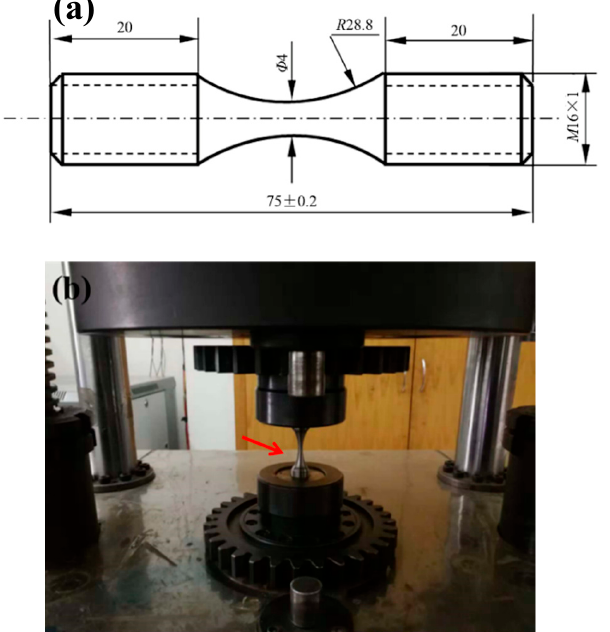
Figure 2. ( a ) Geometry of a diabolo specimen used for the uniaxial tensile fatigue test (dimensions in mm) and ( b ) the fixed fatigue specimen during HCF test.